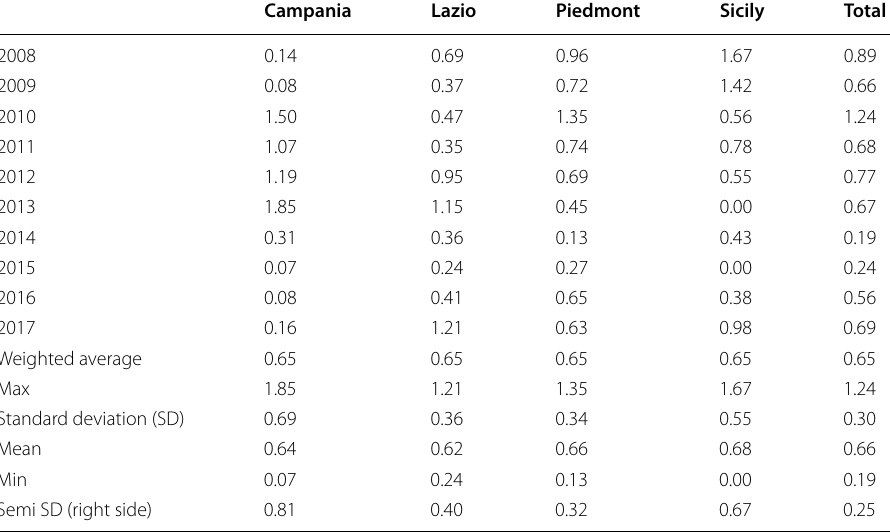
Table 7 Loss ratio (compensations/contributions) by region and